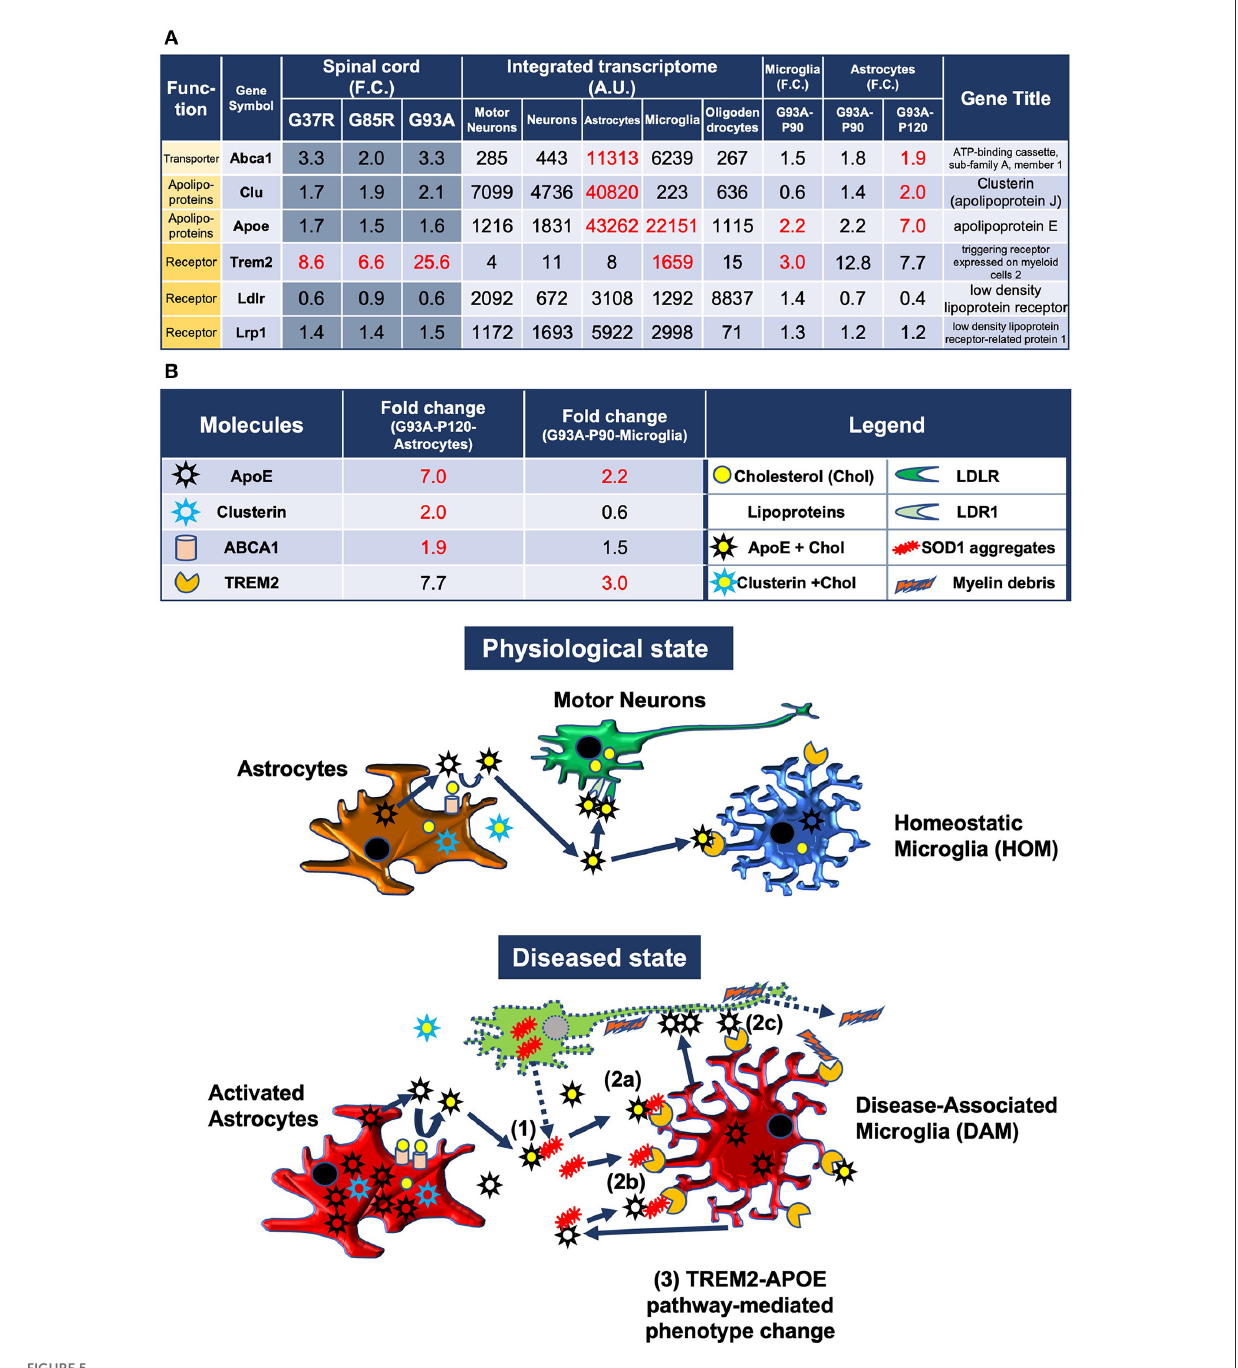
FIGURE5 Model of the pathomechanism among different cell types in spinal cords of mutant SOD1 mice related to TREM2, apolipoprotein E, and lipoproteins. (A) Gene expression analysis of the relevant transporter Abca1 , apolipoproteins Apoe and Clu , and receptors Trem2, Ldlr , and Lrp1 , using integrated and SOD1 G93A cell type transcriptomes. (B) Physiological state: cholesterol is transported from astrocytes to motor neurons and microglia via lipoproteins. Diseased state: (1) Mutant SOD1 aggregates are released from diseased motor neurons and bind to lipoproteins in the intercellular space. (2a) Microglia phagocytose SOD1 aggregate-lipoprotein complexes via TREM2. (2b) Microglia phagocytose SOD1 aggregates with or without ApoE via TREM2. (2c) Microglia phagocytose ApoE-bound motor neurons via TREM2. (3) TREM2-mediated phagocytosis changes the phenotype from HOM to DAM in microglia via ApoE signaling. Excessive DAM activation may contribute to exacerbation of ALS